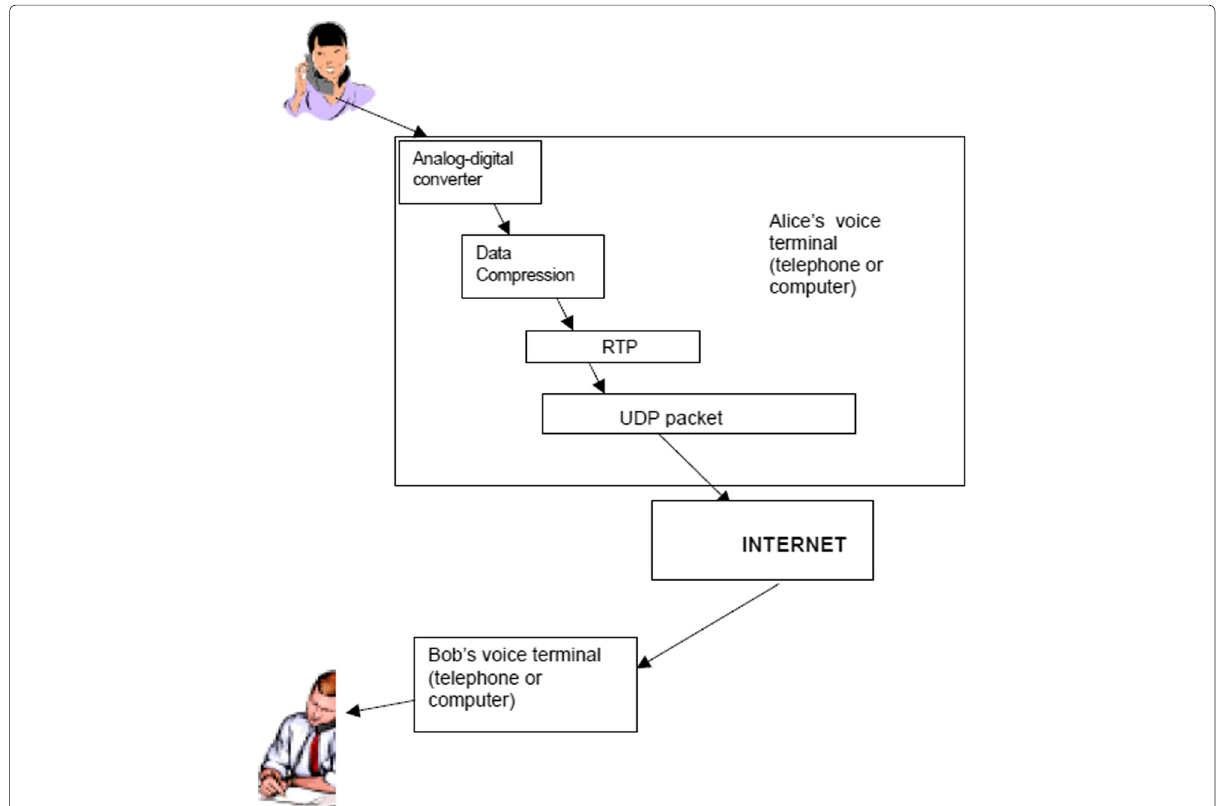
Fig. 1 Voice data processing in a VoIP system